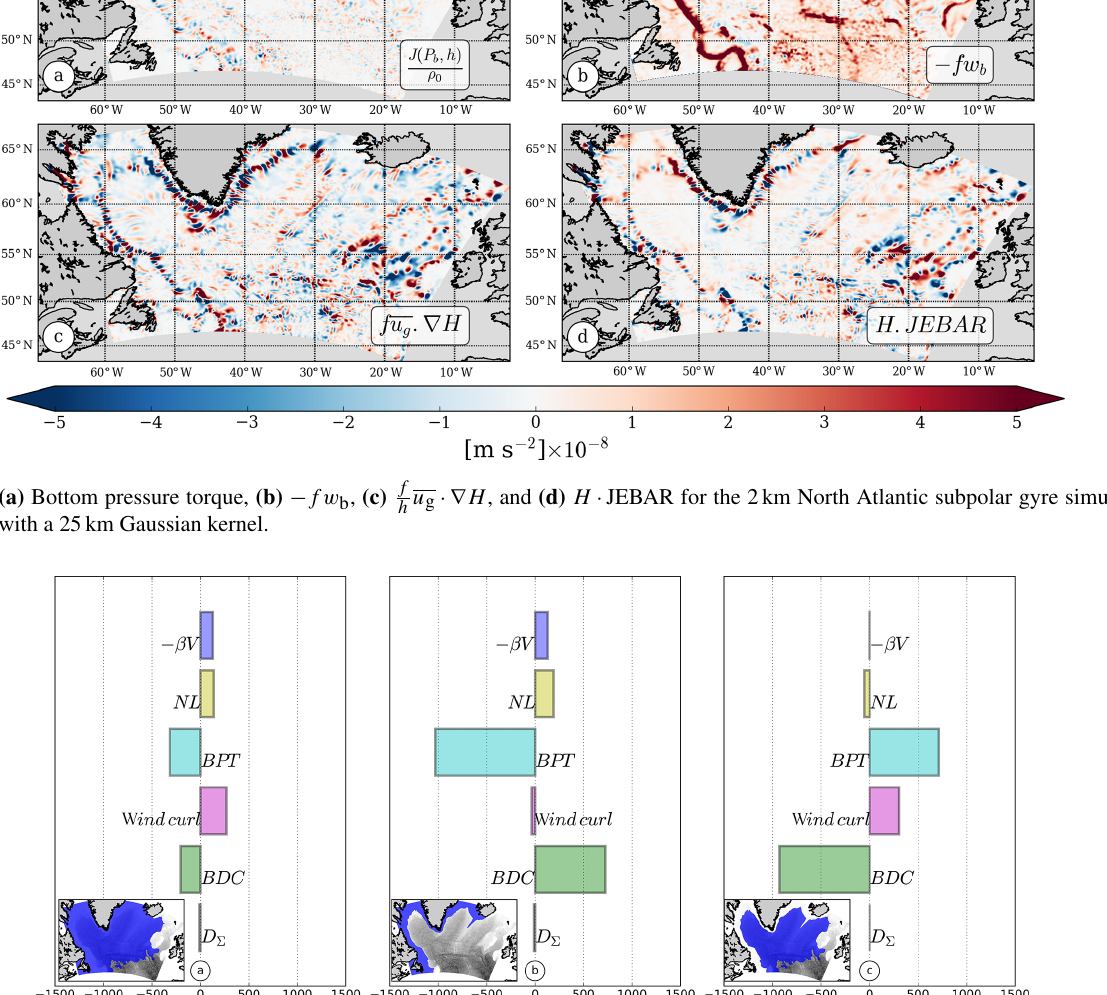
Figure 9. Integration of the barotropic vorticity terms over the SPG including or excluding the shelf area (panels a and c , respectively). The subpolar gyre area without the shelf corresponds to the − 3Sv contour. The shelf balance is plotted in (b) .